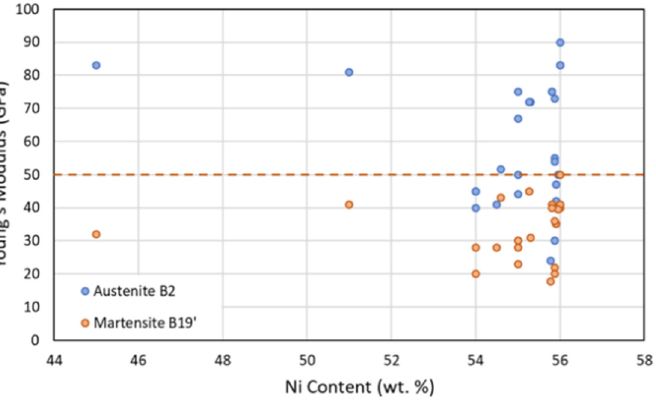
Figure 6. Scatter plot showing elastic modulus of the martensite and austenite phases plotted with the Ni content, from past published sources [1,34,36,38,40,50–73]. the Ni content, from past published sources